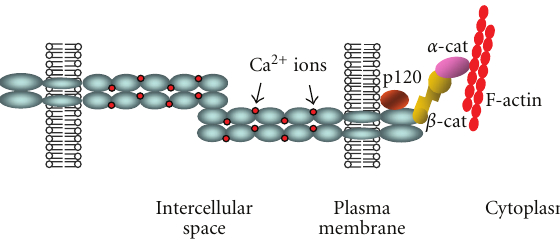
Figure 1: Schematic overview of the classical cadherin-catenin complex. Classical cadherins (blue), which mediate calcium- dependent (red) intercellular adhesion, are composed by an extracellular domain, a transmembrane domain and a cytoplasmic domain. This one comprises a juxtamembrane domain, which binds to p120-catenin (orange), and a catenin-binding domain, which binds β -catenin (yellow). β -catenin binds to α -catenin (violet), which establishes a direct link between the cadherin- catenin complex and the actin cytoskeleton